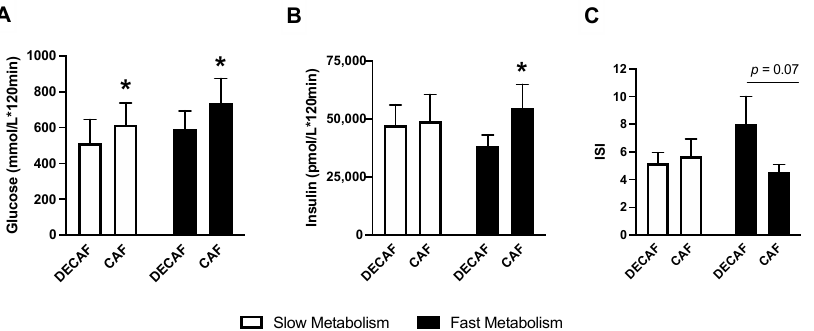
Figure 2. Genetic influences of ca ff eine-containing energy shot consumption on glucose and insulin tolerance. Subjects were classified as having either a low (slow ca ff eine metabolism, n = 9) or high (fast ca ff eine metabolism, n = 11) allele score based on variation at rs762551, rs4410790, rs2470893, rs2472297 and rs2472299 as described by Nordestgaard [19]. ( A ) Blood glucose AUC, ( B ) Insulin AUC, ( C ) Matsuda insulin sensitivity index (ISI) [22] in participants classified with slow or fast ca ff eine metabolism. All data are shown as means ± SE, n = 20 subjects in a randomized, cross-over design. * Indicates p < 0.05, a statistically significant di ff erence between